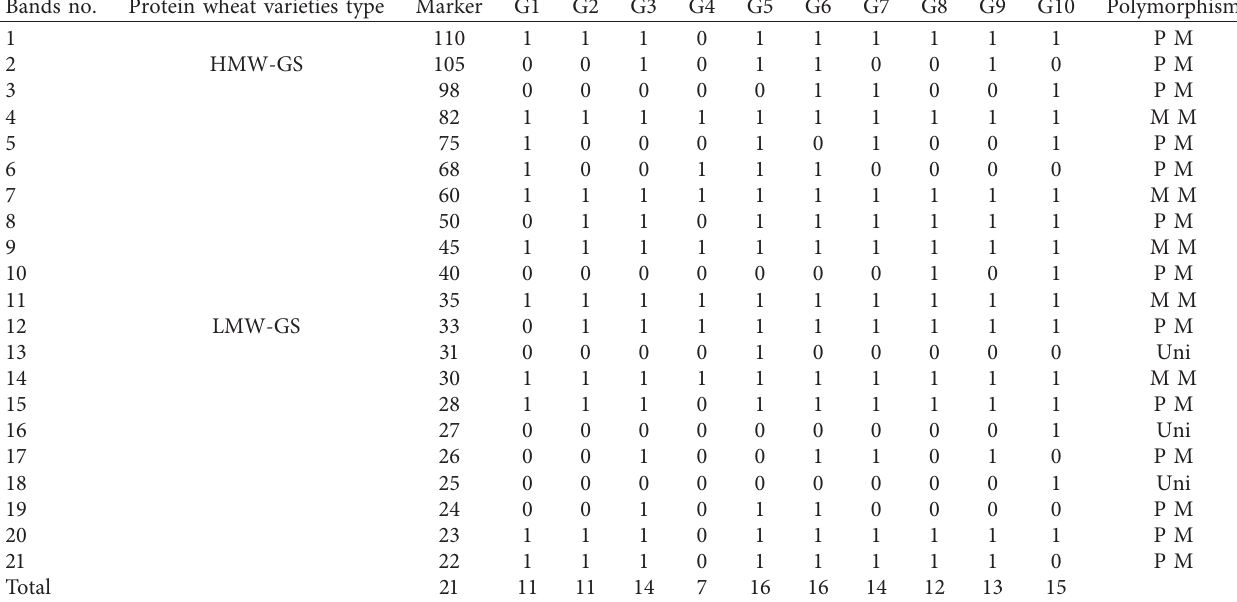
Table 9: Molecular weight analysis of the 10 wheat varieties obtained by SDS-PAGE. Bands no. Protein wheat varieties